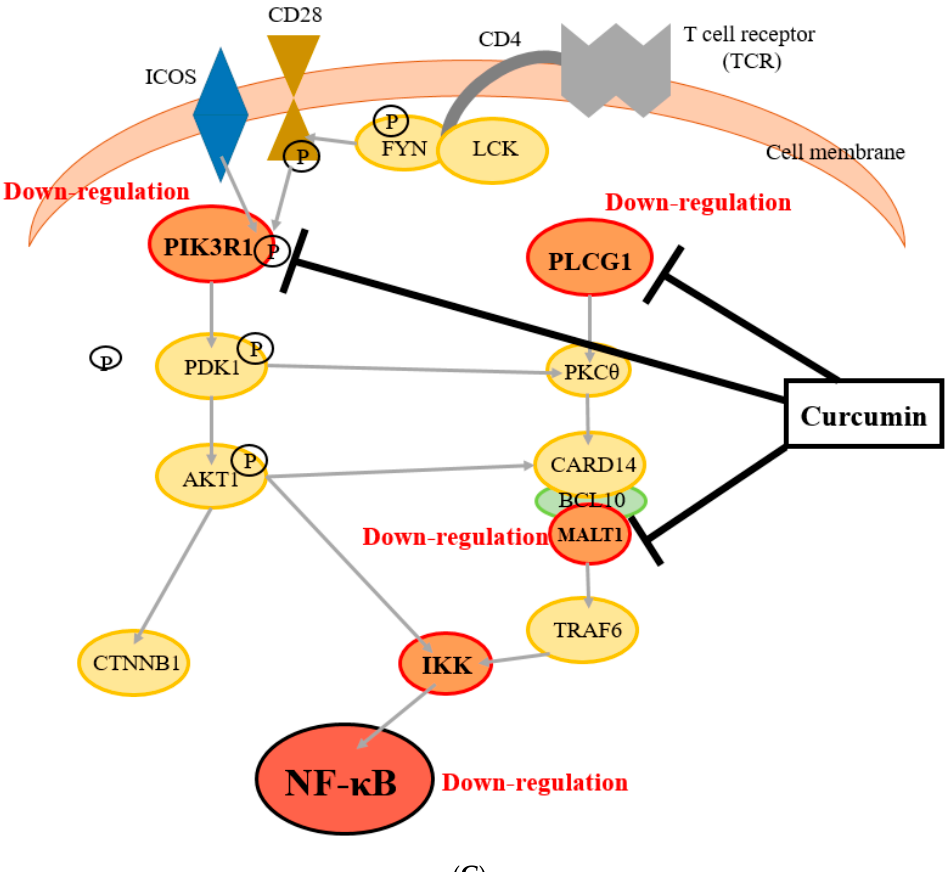
Figure 3. Using ConsensusPathDB (CPDB) to identify novel modulation by curcumin. ( A ) Prediction of high correlation pathways. Genes common between two sample sets were used to query CPDB in order to predict the pathways in which these genes were likely participating. The network shows the 20 highest-scoring pathways from CPDB. The size of each dot denotes the entity number of genes in the pathway. The line between two dots was calculated by the function of these two pathways to indicate the number of genes overlapping said pathways. The breadth of the line denotes the strength of the correlation between two dots. The yellow star denotes the pathway selected for validation. Details regarding the analysis of these 43 pathways are listed in Figure S2. ( B ) Curcumin reduced MALT1, PIK3R1, and PLCG1 expression. Most of the HT29 and Huh7R cells were dead after 48 h. The intensity of each protein expression band was quantified through densitometry normalization to that of GAPDH, with the control level arbitrarily set to 1. All data are presented as means ± SEMs. Means without common letters differed; p < 0.05. ( C ) Proposed mechanism of curcumin on the CD4-T-cell-receptor-signaling NF- κ B pathway.